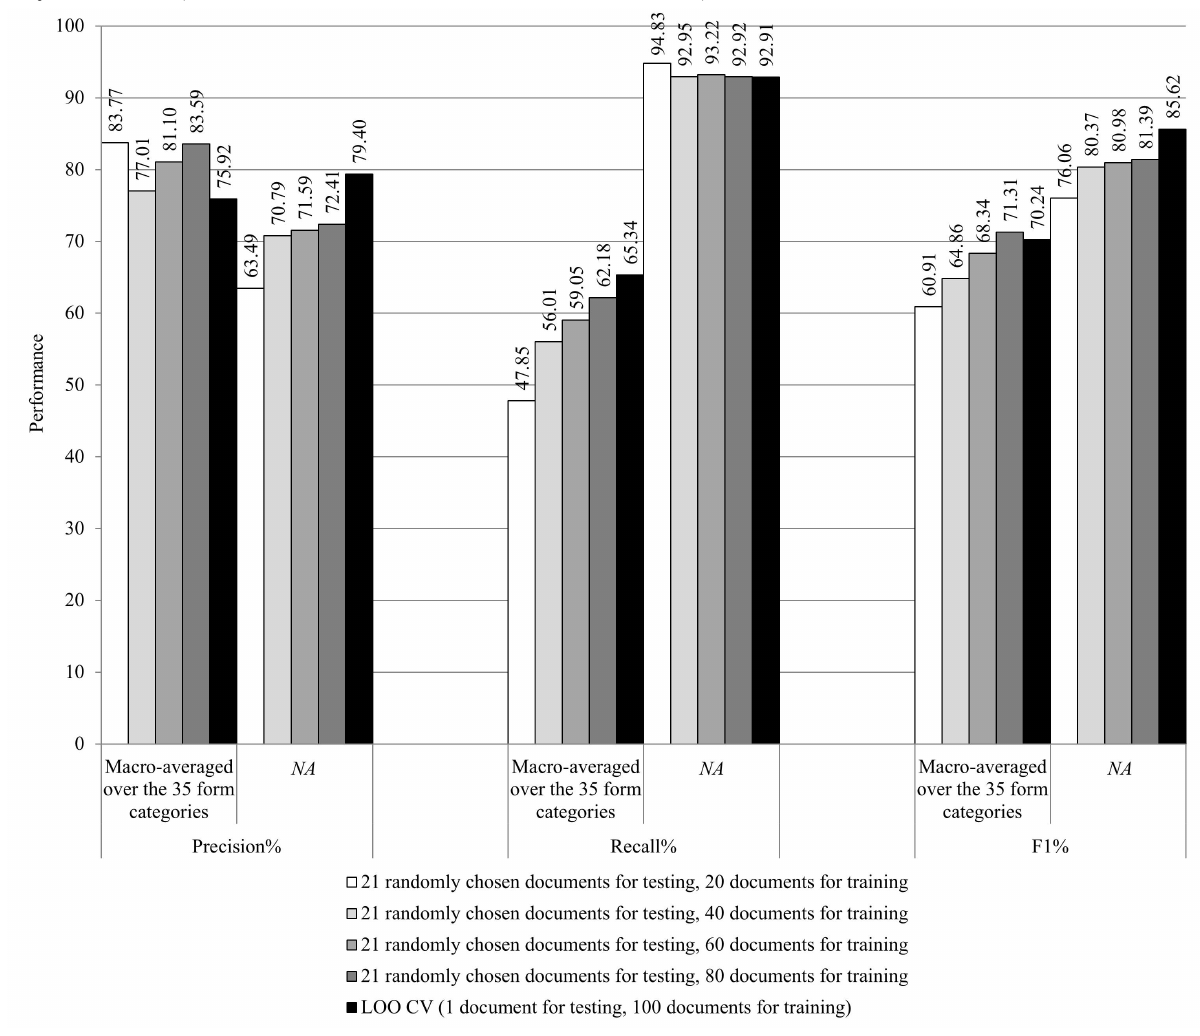
Figure 5. Learning curves for cross-validation settings that included training set sizes of 20, 40, 60, 80, and 100 (ie, leave-one-out) documents with mutually exclusive folds, which in combination covered all data. CV: cross validation; and LOO: leave one